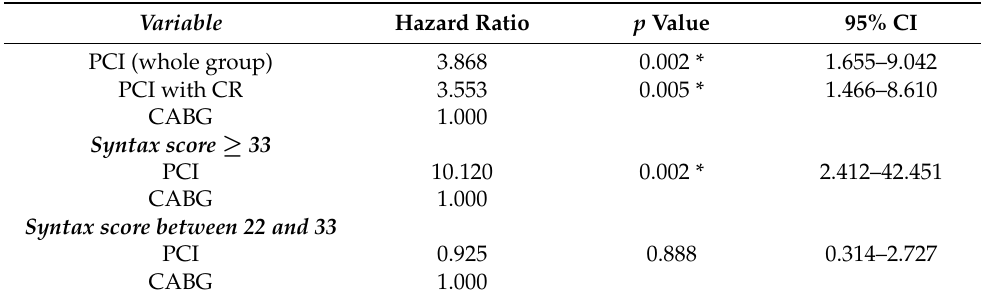
Table 3. Hazard ratio of 3-year HF hospitalization when PCI compared to